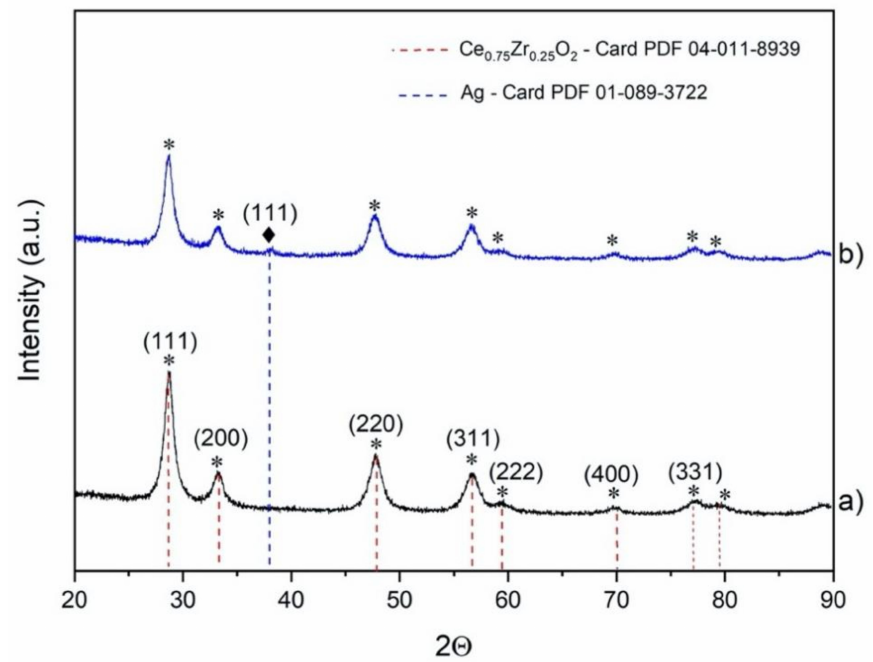
Figure 1. XRD pattern of ( a ) synthetized support Ce 0.75 Zr 0.25 O 2 and ( b ) synthetized catalysts: 5 wt% of Ag impregnated on Ce 0.75 Zr 0.25 O 2 catalyst. Symbols correspond to: ( ∗ ) Main peaks of the